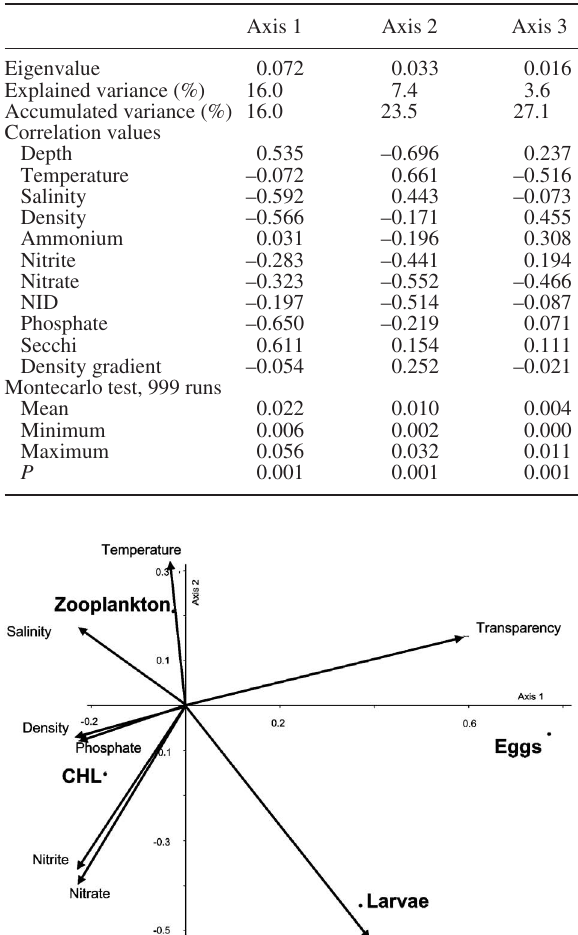
Table 3. – Axis eigenvalues and explained variance (%) from a canonical correspondence analysis using Sardinops sagax egg and larval abundance, chlorophyll a and zooplankton at each of the 92 stations during winter and early spring 2005-2009 in Bahía Magda- lena, Baja California Sur.